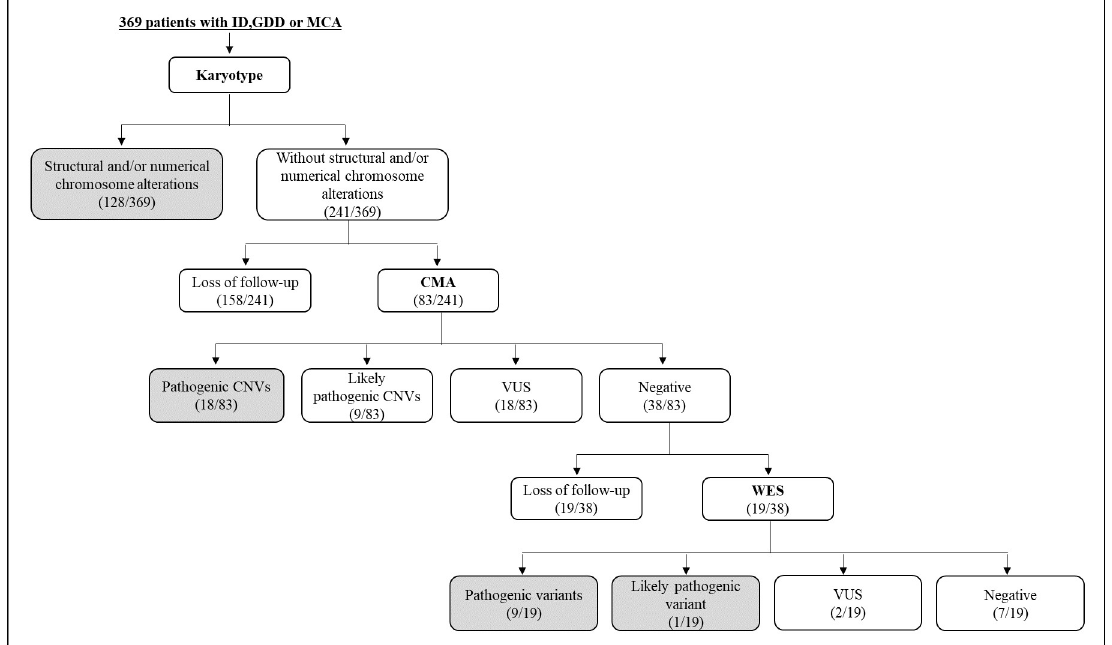
Fig 1. Diagram of the testing workflow and number of cases in each step for the genetic diagnosis of ID, GDD and MCA from Central Brazil. The highlighted rectangles indicate the total of cases for which diagnoses were reached.